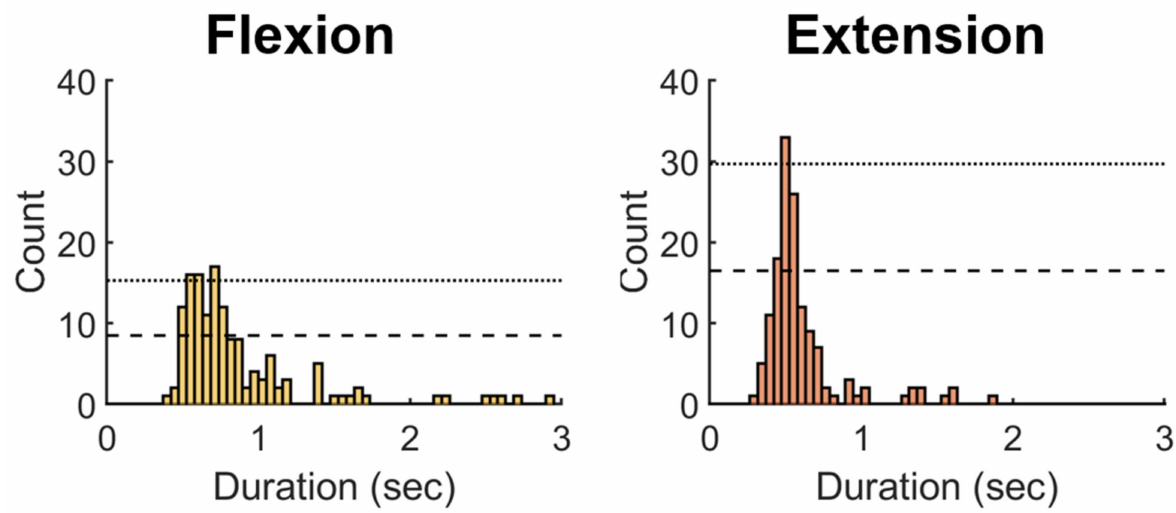
Figure 3. Histogram of the time spent for fingers flexion and extension that were estimated from the inferred images. The dotted and dash line represented the 90% and 50% value of the maximum count, respectively. The duration ranges include the bars of count larger than or equal to the 90% and 50% value were defined as D 90 and D 50 ,